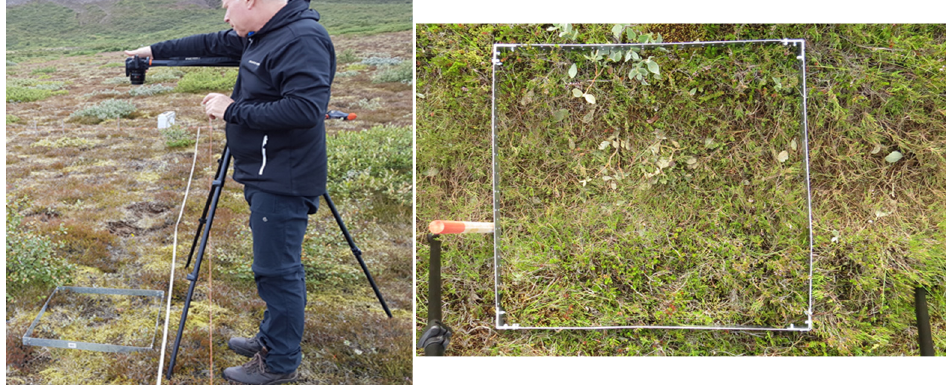
Figure 3. The tripod stand for photo acquisition of the subplots ( left ). A photograph of a subplot ( right ).